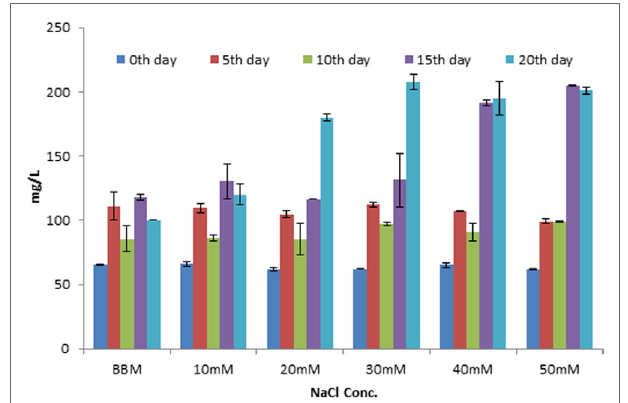
FigUre 3 | estimation of total lipid content in Scenedesmus quadricauda in different salt stress condition .